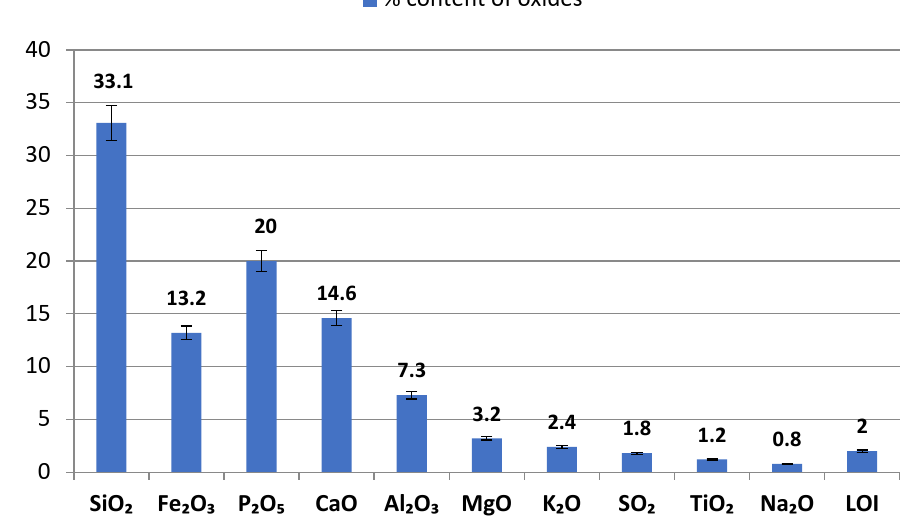
Figure 4. Chemical composition of fly ash from municipal sewage sludge